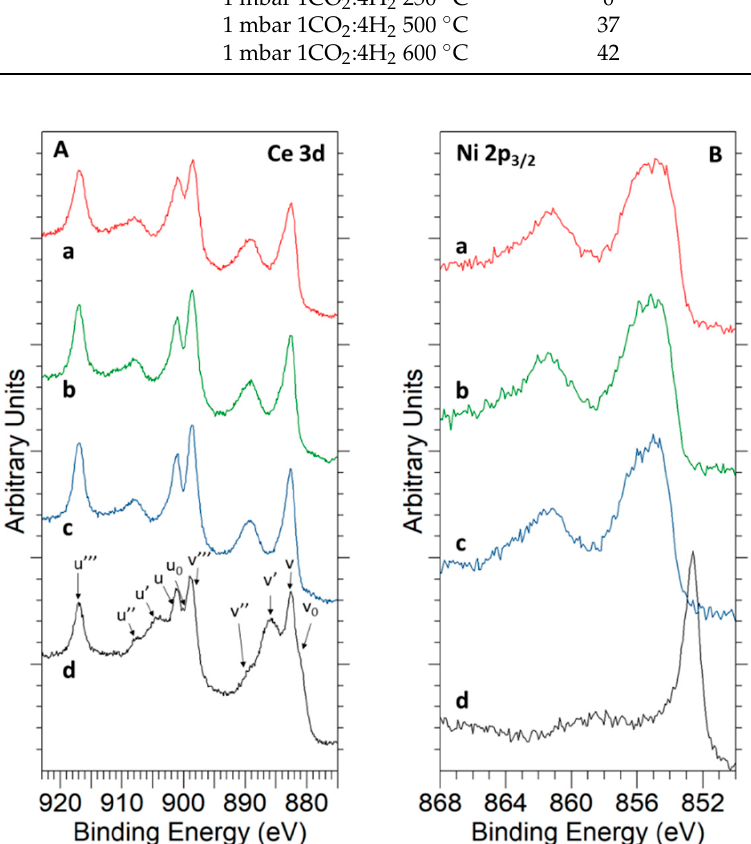
Figure 5. NAP-XPS spectra recorded at KE = 190 eV for Ce 3 d ( A ) and Ni 2 p 3/2 ( B ) core levels of the 5Ni-CeO 2 NCs catalyst during reduction under hydrogen (1 mbar) at different temperatures: (a) 250 ◦ C, (b) 300 ◦ C, (c) 350 ◦ C, and (d) 500 ◦ C. Ce 3d peaks assignments as proposed by the authors of [53]. For further details of the Ni 2p 3/2 peak decomposition, see Supplementary Materials File, Figures S5 and S6.